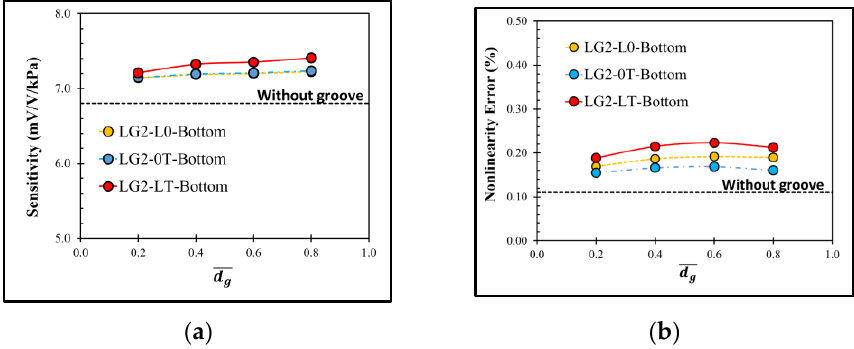
Figure 12. Variations of ( a ) sensitivity and ( b ) nonlinearity error with dimensionless groove depth of sensor with local grove 𝐿𝐺2 at the bottom of diaphragm at 𝑙 𝑔 ̅ = 0.175 .